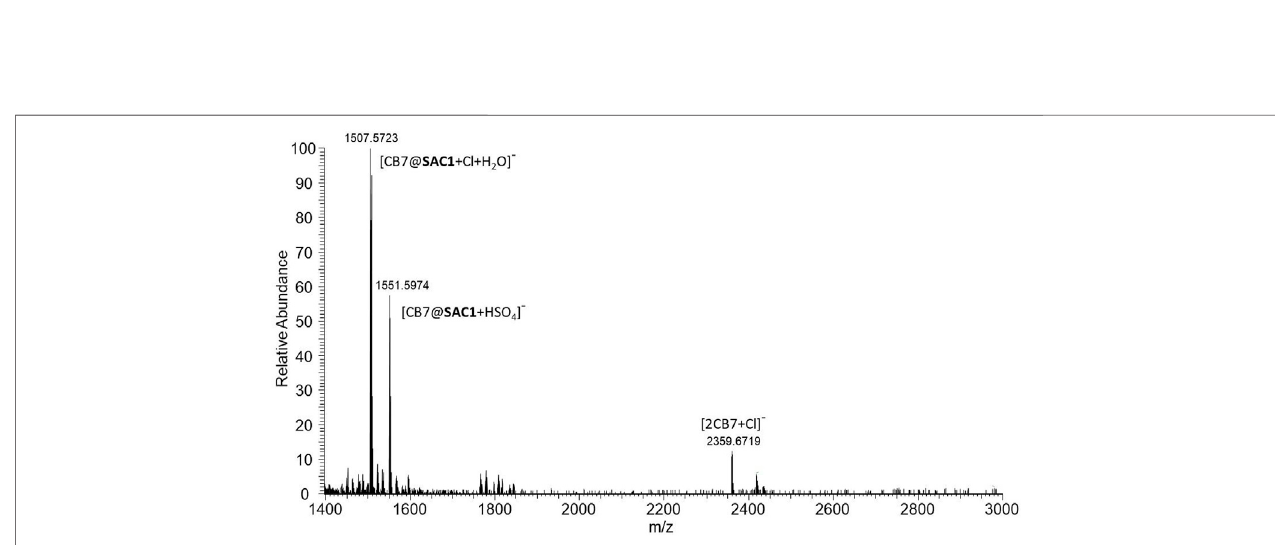
FIGURE 4 | ESI-HRMS (Ionization voltage: 3.5 kV and negative polarity) for 1.5 µM of SAC1 in the presence of 1mM of CB7, dissolved in a methanolic solution at 30%(v/v)and pH2.5.Scanparameters:Resolution:140000,AGC target:1×10 6 ,Max.inject time:200.HESIsource: Sheathgas fl ow:25,Aux gas fl owrate:3,Sweep gas fl ow rate: 0, Capillary temp.: 250 ° C, S-lens RF level: 100, Heater temp: 100 ° C.